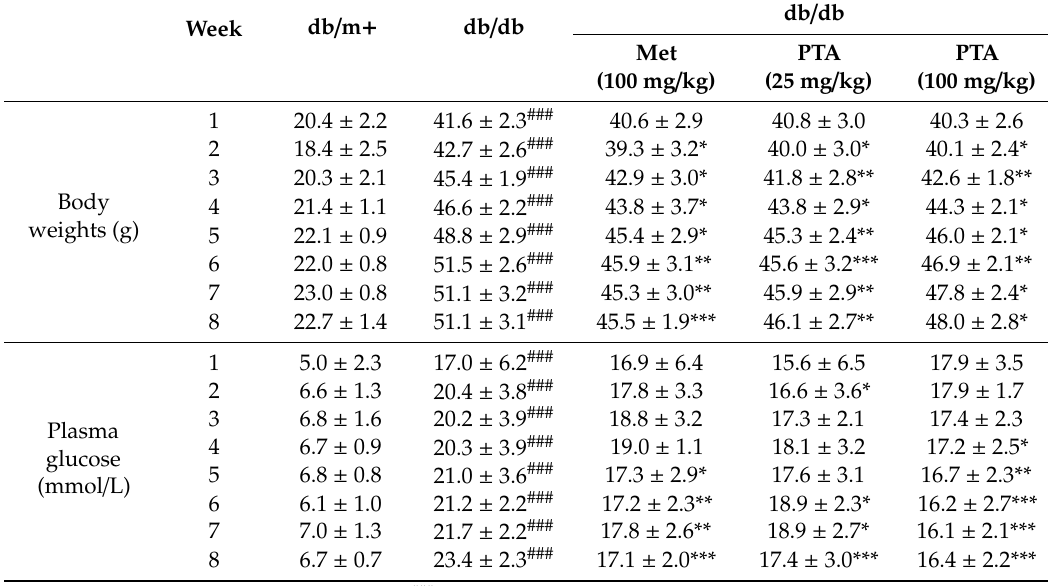
Table A1. The e ff ects of Met and PTA on the changes in bodyweight, plasma glucose, and food and water intake of